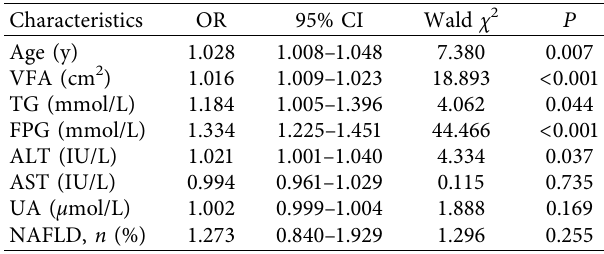
Table 2: Univariate logistic regression analysis of factors affecting IR. Characteristics